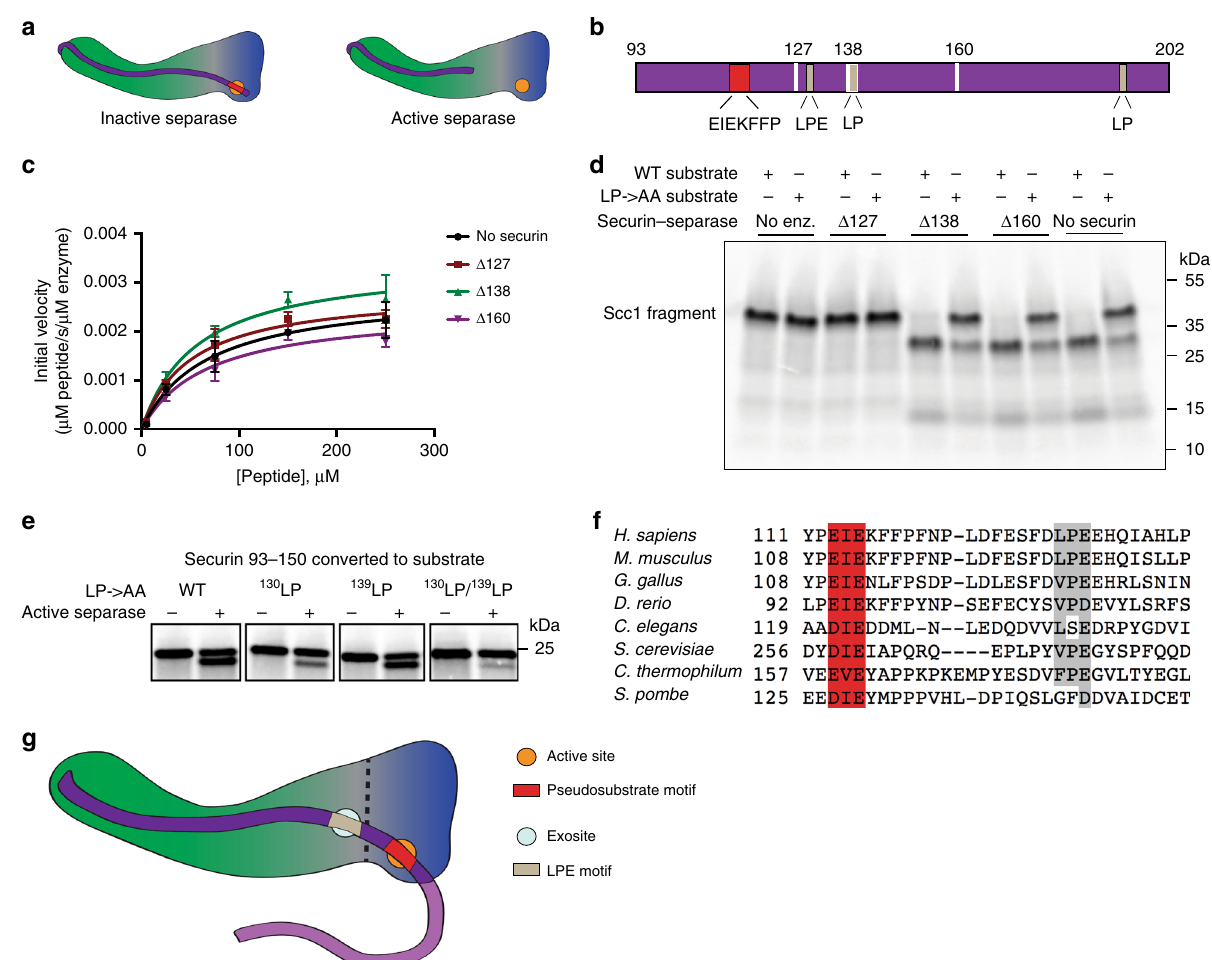
Fig. 4 Securin inhibits binding to the LPE motif of Scc1. a Cartoon of the securin-separase fusion protein containing the full separase-binding region of securin (left) or with securin truncated on the C-terminal side of the pseudosubstrate motif (right). The separase active site (orange) and pseudosubstrate motif (red) are indicated. b Diagram of the human securin sequence, indicating the locations of the pseudosubstrate sequence (EIEKFFP), all LP sites including the 130 LPE motif, and the positions of the three truncations tested. See Supplementary Figs. 1b and 7 for amino acid sequences. c Michaelis – Menten analysis was performed with the three indicated securin Δ -separase fusion proteins and compared with puri fi ed separase lacking securin. Initial velocity was normalized by enzyme concentration. Data points indicate means (±SD) of triplicate samples. See Supplementary Fig. 8 for a control experiment with securin that includes the pseudosubstrate motif. Source data are provided in the Source Data fi le. d 35 S-labeled Scc1 fragments (aa 142 – 300), with or without mutations in the 255 LPE motif, were incubated with the three indicated securin Δ -separase fusion proteins or with puri fi ed separase lacking securin. Reaction products were analyzed by SDS-PAGE and Phosphorimaging. e The pseudosubstrate motif in securin was converted to